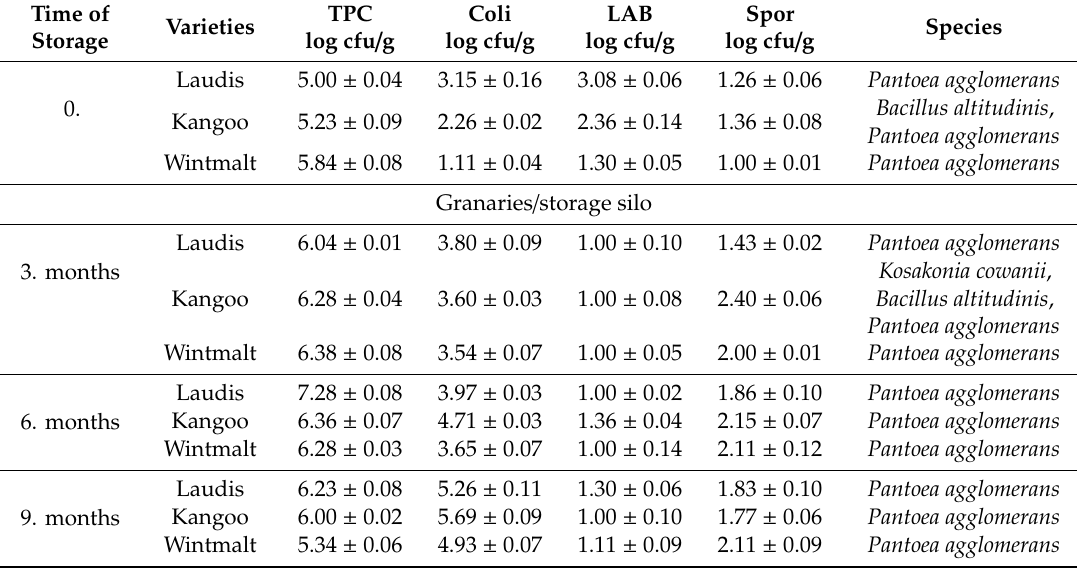
Table 3. Quantitative and qualitative composition of various groups of microorganisms from three varieties of barley, depending on the time and type of storage. Time